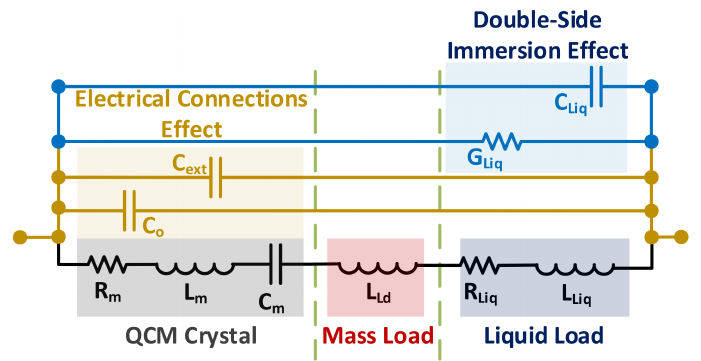
Figure 4. Detailed BVD model of a loaded QCM crystal in liquid.